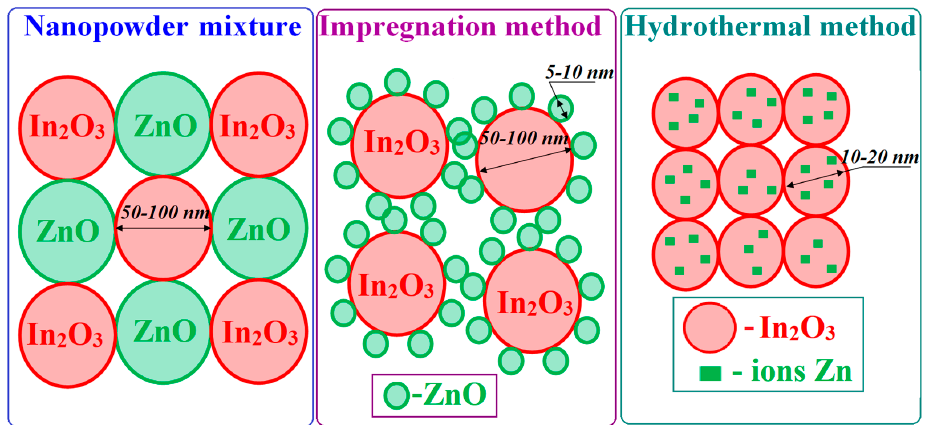
Figure 4. The schematic representation of ZnO–In 2 O 3 composites structure synthesized by different